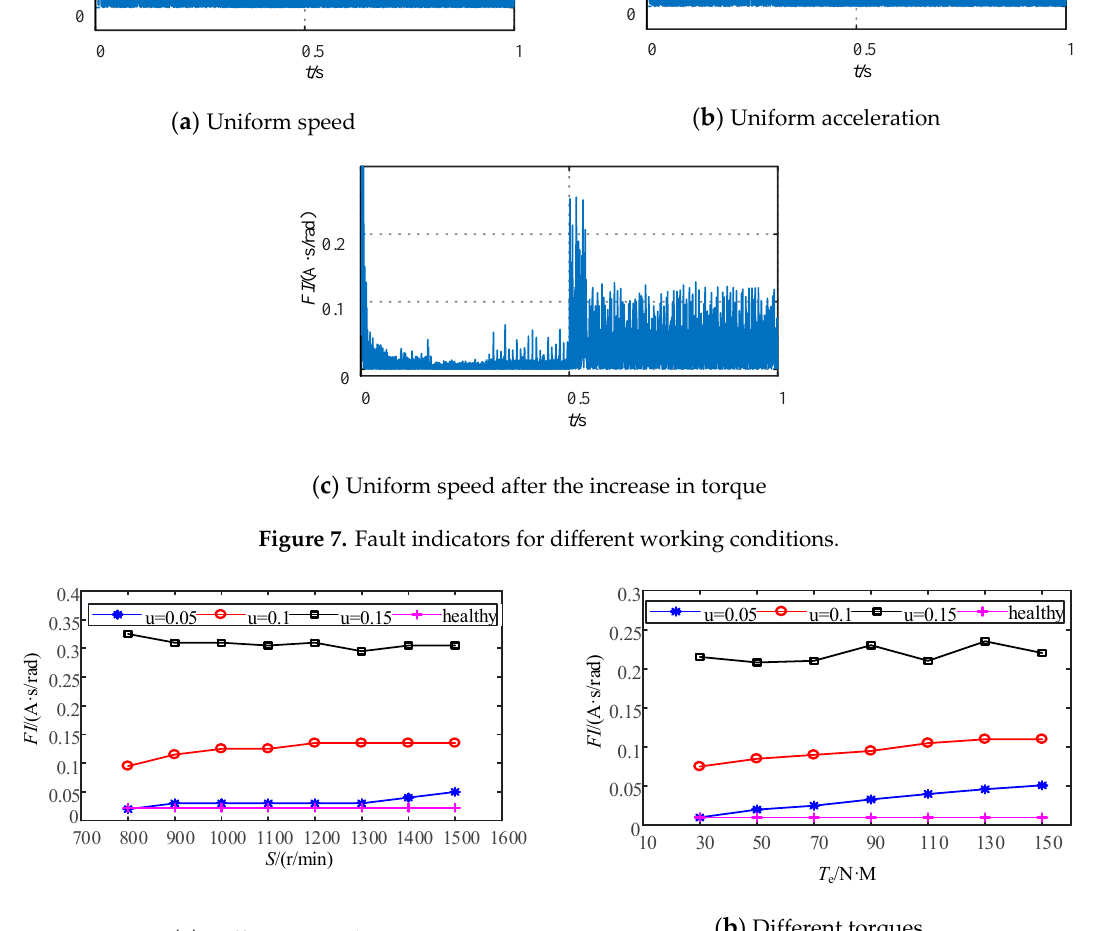
Figure 8. Fault indicators for different degrees of fault.